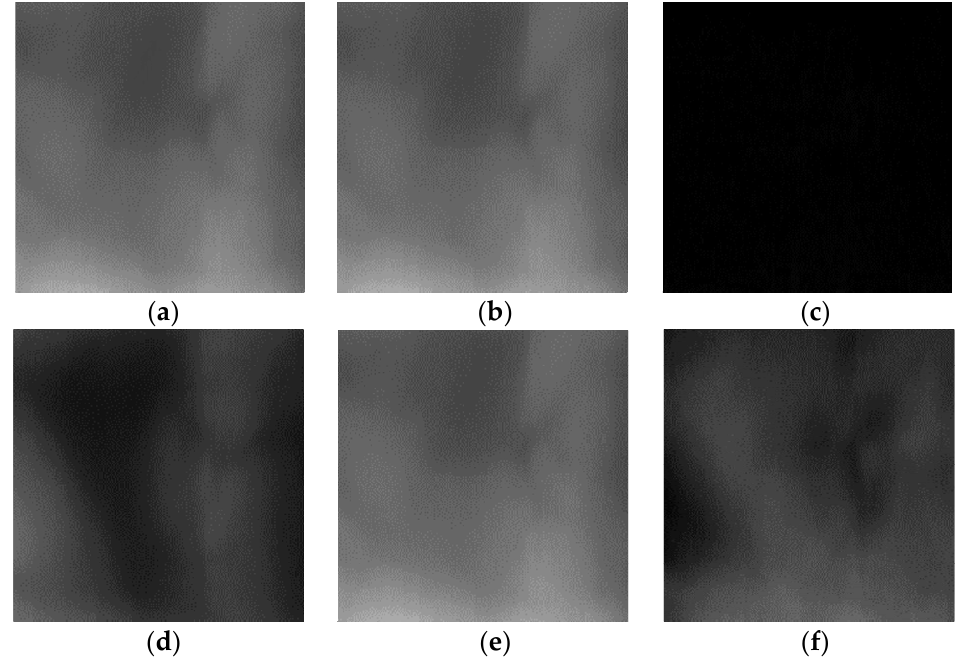
Figure 5. Examples of input and enrolled images with their corresponding difference images: ( a ) input image and ( b ) enrolled image in same class; ( c ) difference image of ( a ) and ( b ); ( d ) input image and ( e ) enrolled image in different class; and, ( f ) difference image of ( d ) and ( e ).